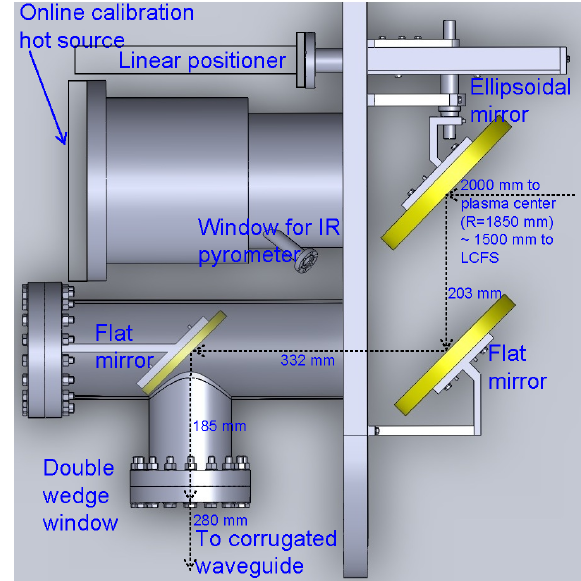
Figure 1. Quasi-optical antenna for the ECE diagnostic on EAST.